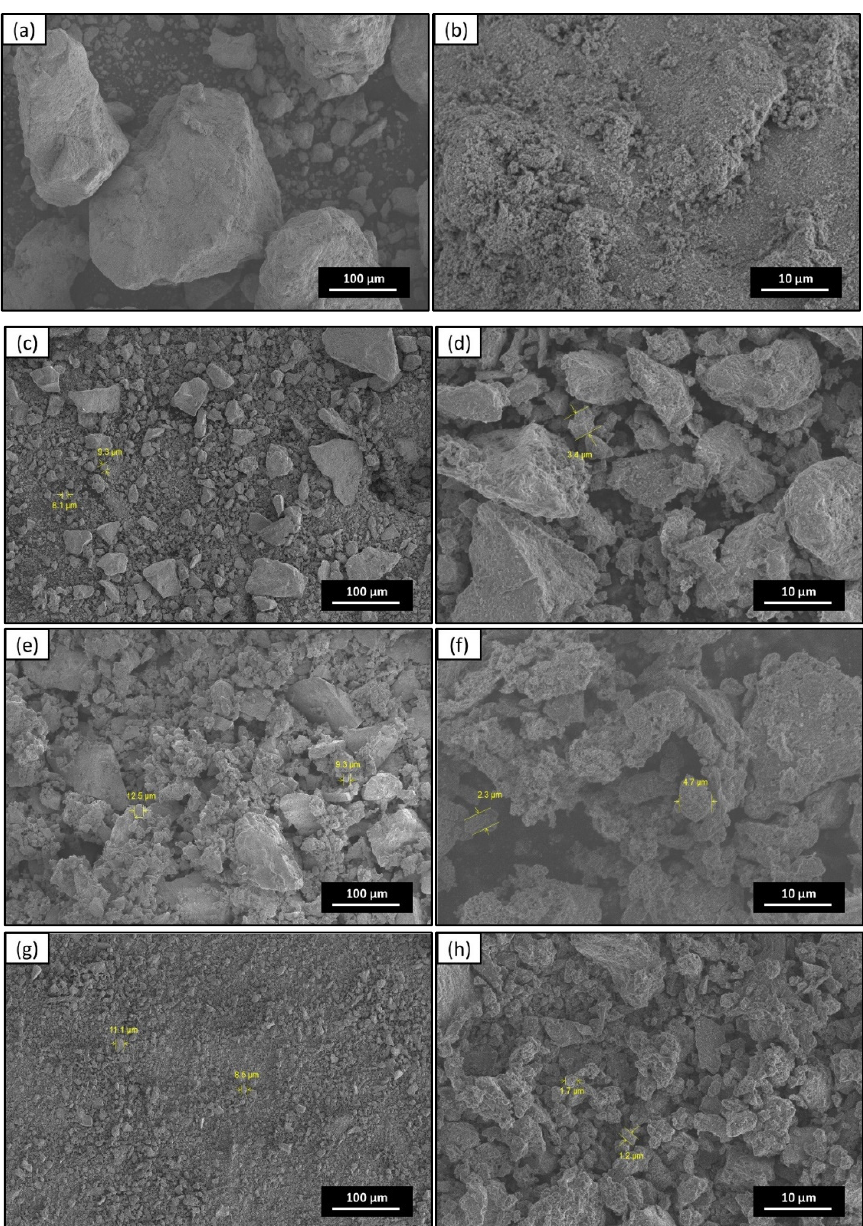
Figure 4. SEM image with of ( a , b ) TiO 2 /NTO, ( c , d ) 1% Au/TiO 2 /NTO, ( e , f ) 2% Au/TiO 2 /NTO, ( g , h ) 3% Au/TiO 2 /NTO.